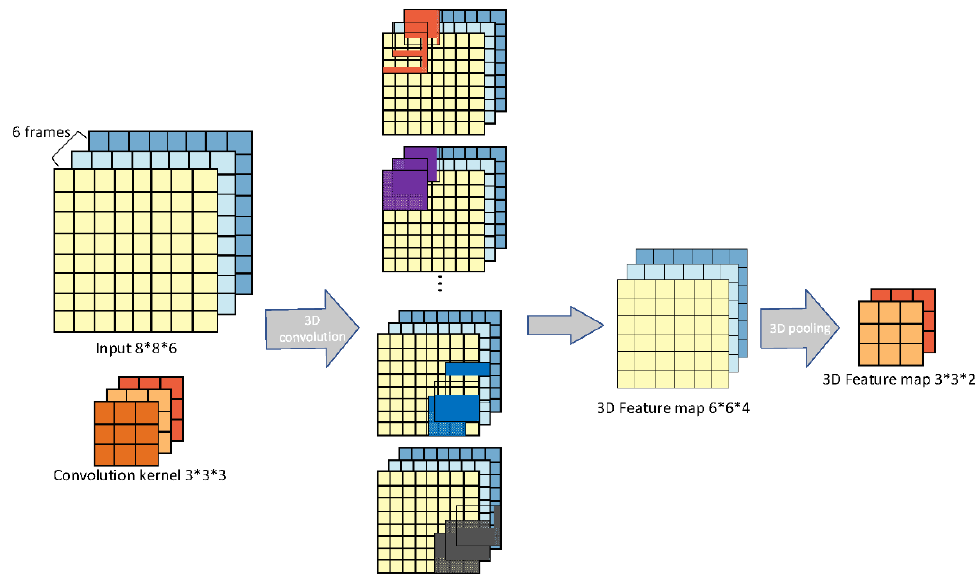
Figure 5. The process of the three-dimensional CNN.